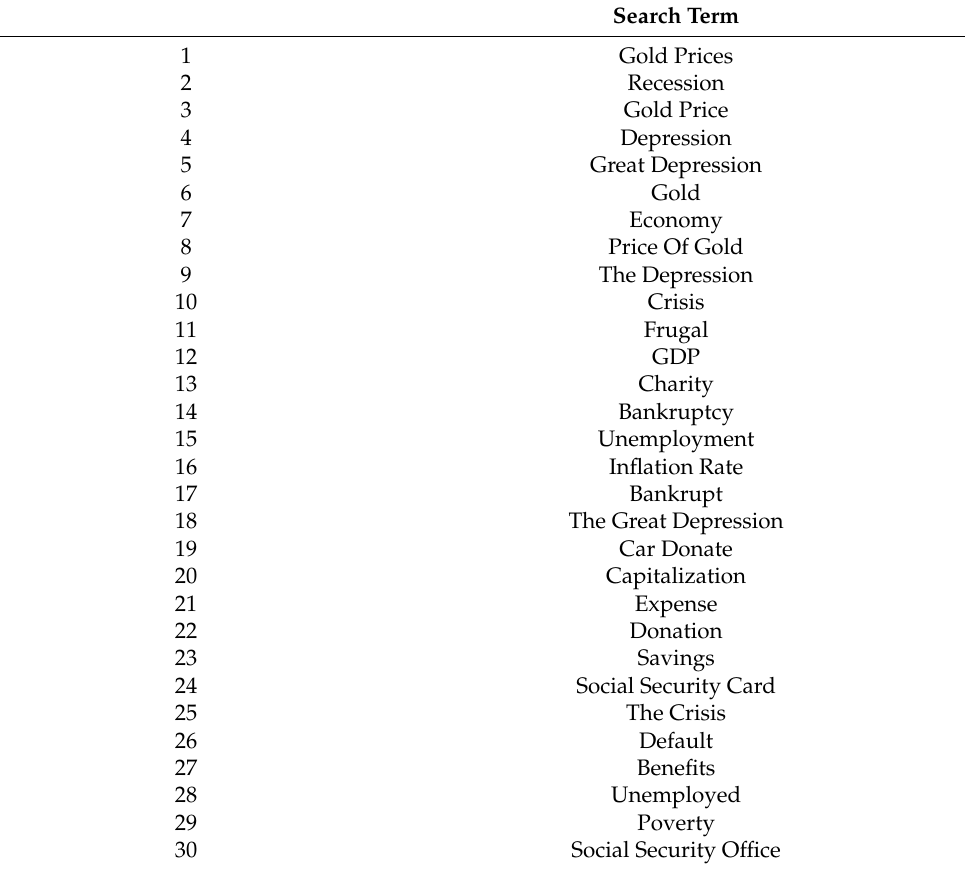
Table 1. List of negative search